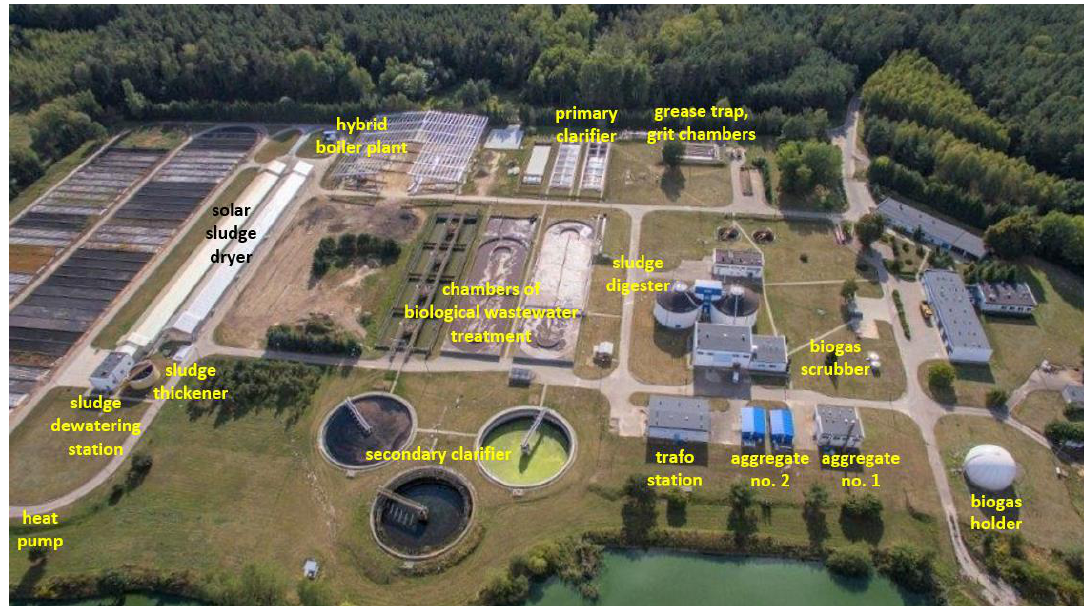
Figure 5. WWTP in Iława ( authors’ own elaboration ).